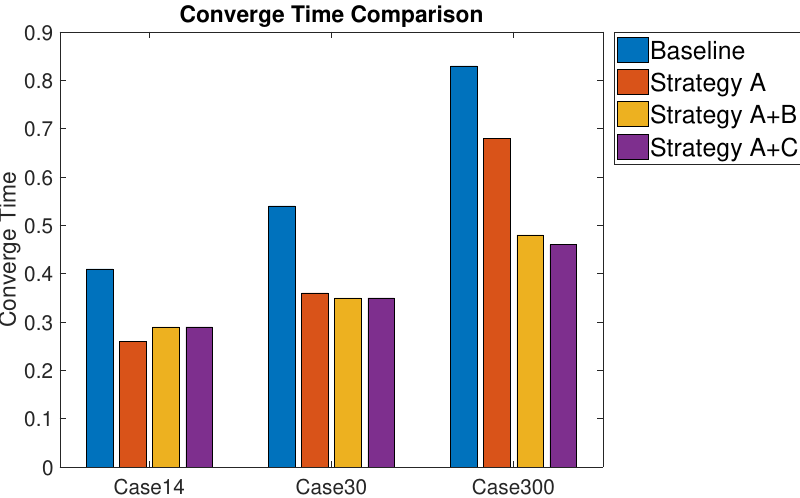
Figure 11. Comparisons in the number of iterations. Strategy A (blue bar) uses only regionalization strategy A until convergence. Strategy A+B (red bar) is the combination of regionalization strategies A and B, Strategy A+C (yellow bar) is the combination of regionalization strategies A and C.